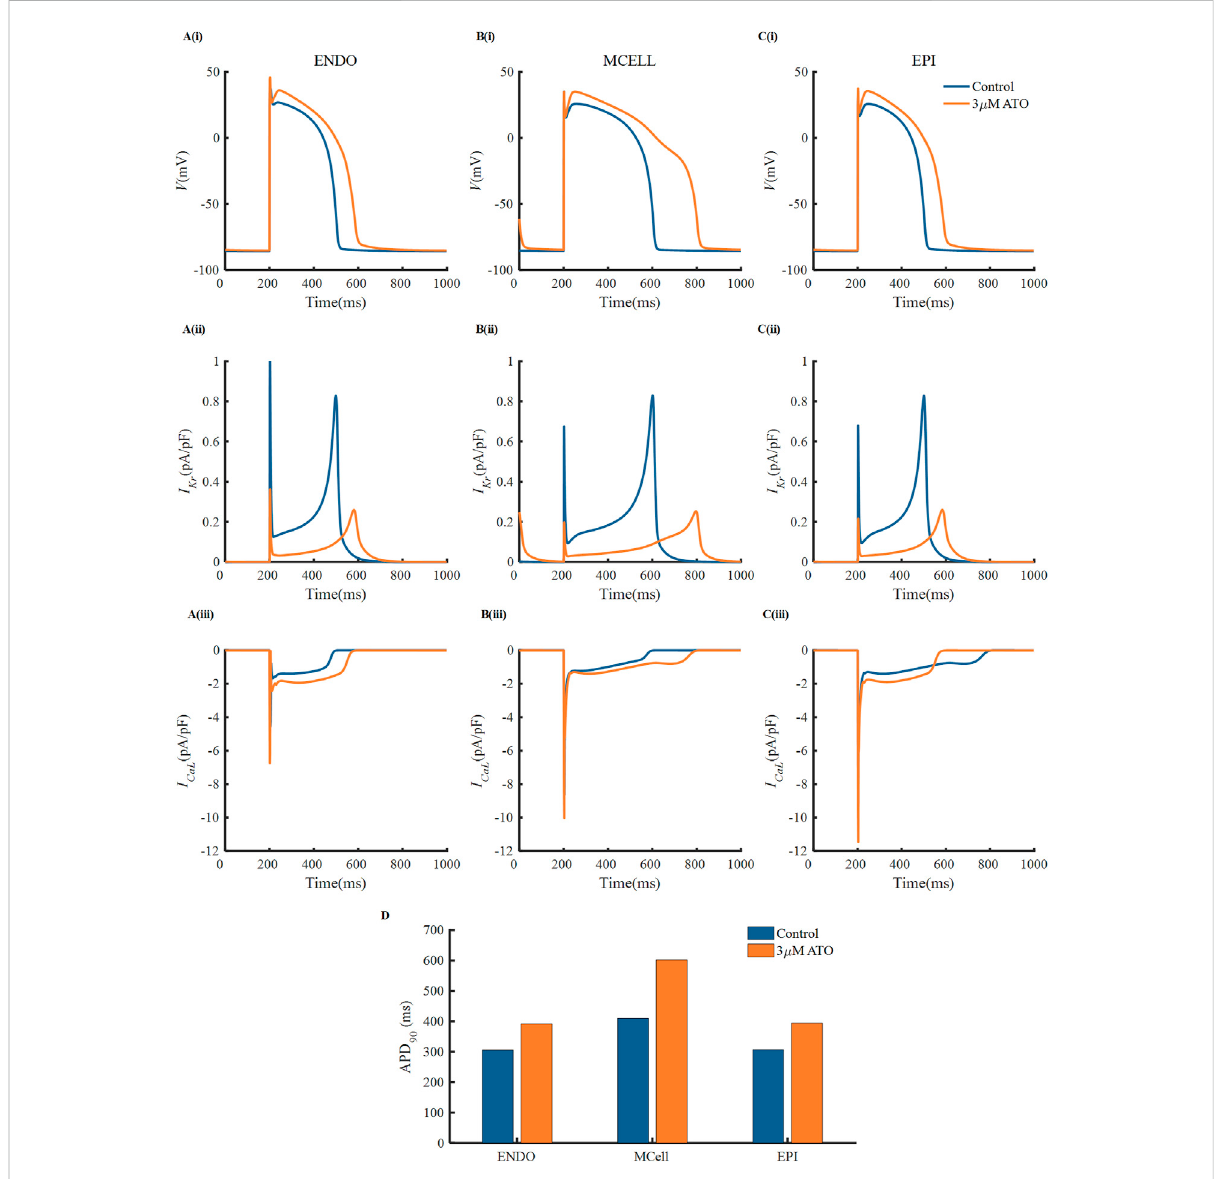
FIGURE 2 The effect of ATO on the action potentials of different ventricular myocytes. (A – C) The membrane potential, (i) ( V ), I Kr (ii) and I CaL (iii)ofendocardialcells(ENDO),middlecells(MCELL)andepicardialcells(EPI)ontheconditionofcontroland3 μ MATO. (D) TheAPD 90 oftheaction potentials in Figure